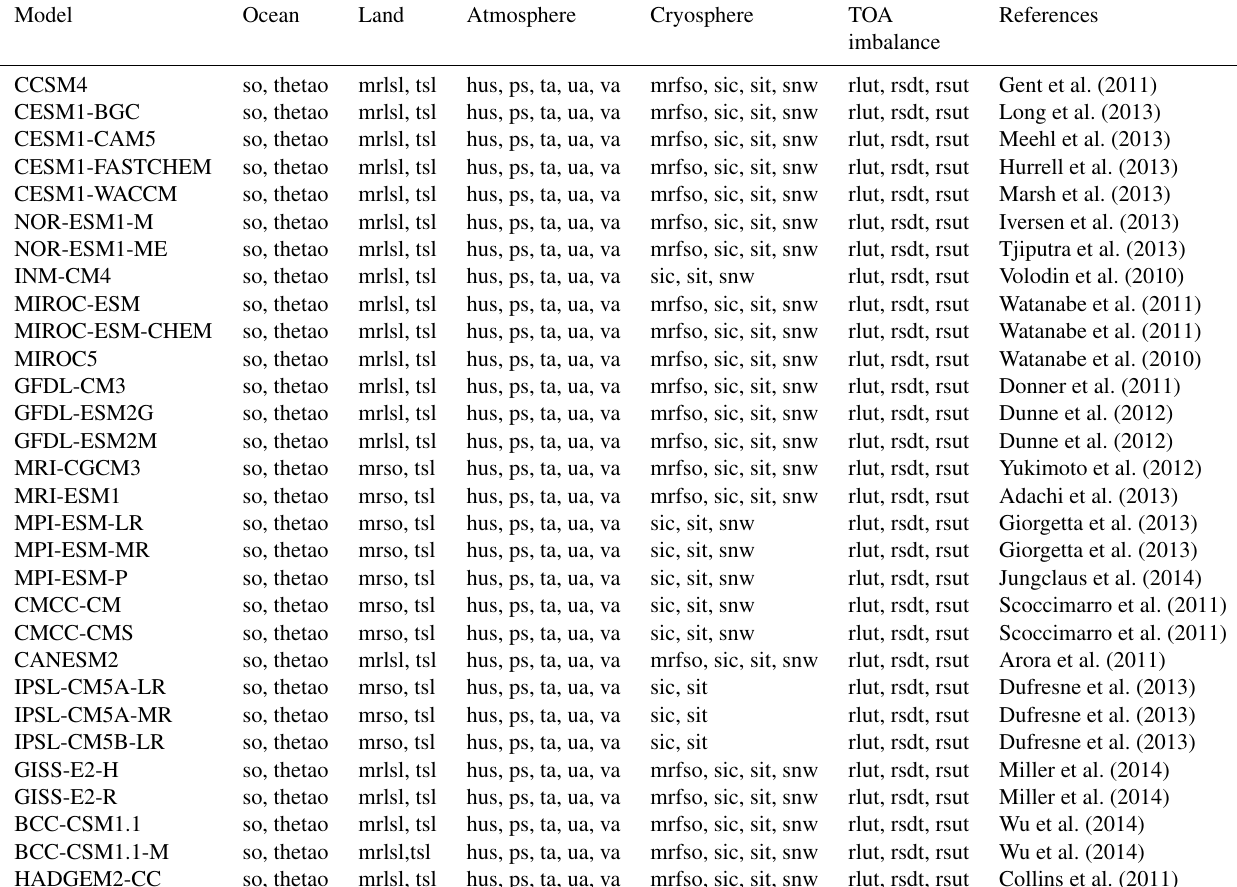
Table 1. Variables from the CMIP5 archive employed to estimate the heat content within each climate subsystem by each GCM (Sect. 2). References for each GCM Historical experiment are also provided. All variables correspond with the r1i1p1 realization of the Historical experiment. A description of all listed variables can be found at the dedicated web page of the Lawrence Livermore National Laboratory (LLNL,